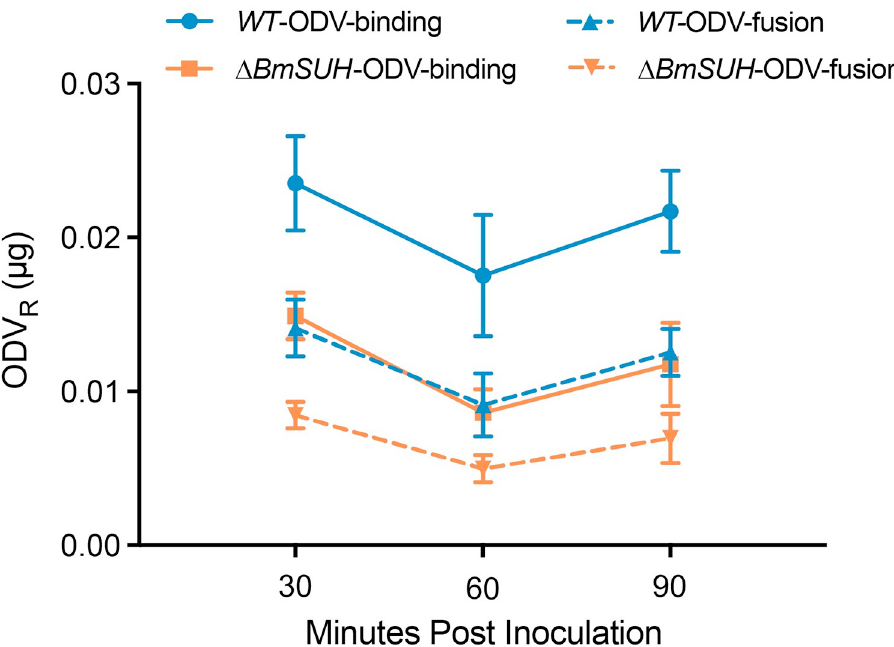
Fig 7. The absence of BmSUH affects the interaction of ODV with midgut epithelium cells. The amounts of labelled ODV R bound (solid line) and fused (dotted line) to the midgut epithelia of fourth-instar WT and Δ BmSUH were detected after larvae feeding of 3 μ g of labelled ODV R from BmNPV and incubated with the designed time (n = 24, per time point). The data were analyzed using the GraphPad Prism 9 software. All data were shown as mean ±